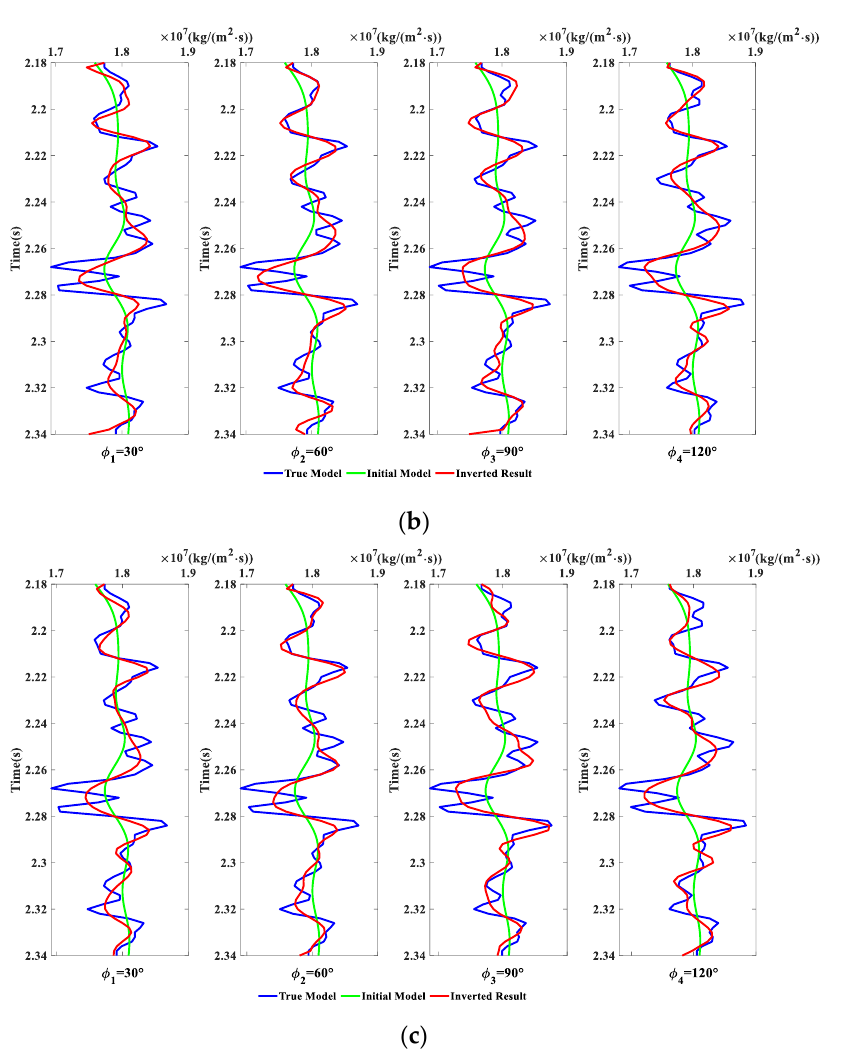
Figure 5. The estimated azimuthal EI with SNR = 2, where ( a ) θ = 10 ◦ , ( b ) θ = 20 ◦ , ( c ) θ = 30 ◦ .